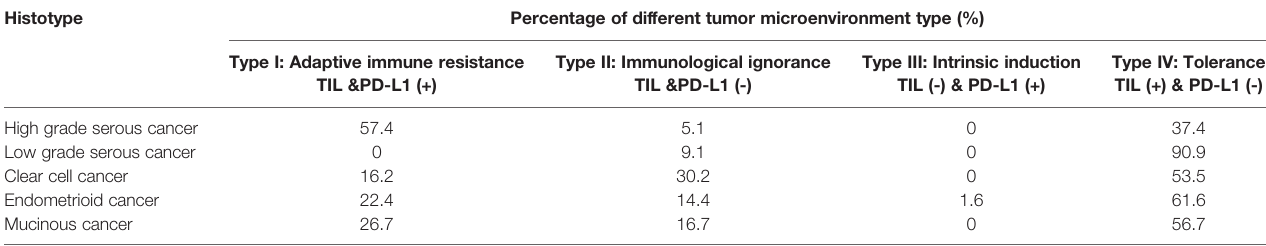
TABLE 1 | The immune subtype distribution in different histotypes of ovarian cancer [based on Webb et al. (37)].